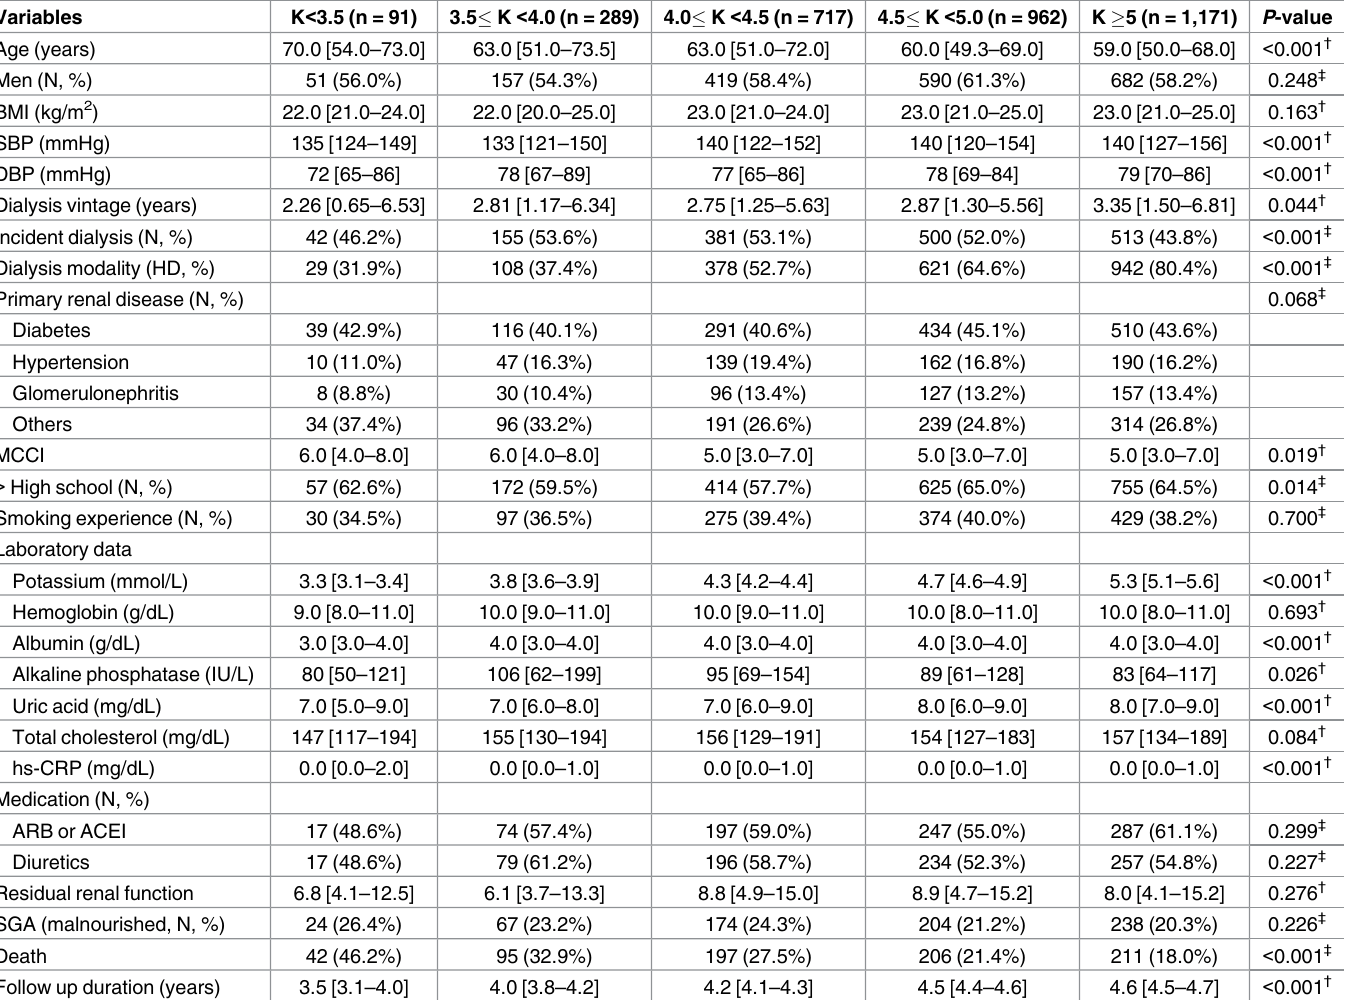
Table 2. Baseline characteristics of end-stage renal disease patients stratified according to serum potassium levels (N = 3,230).